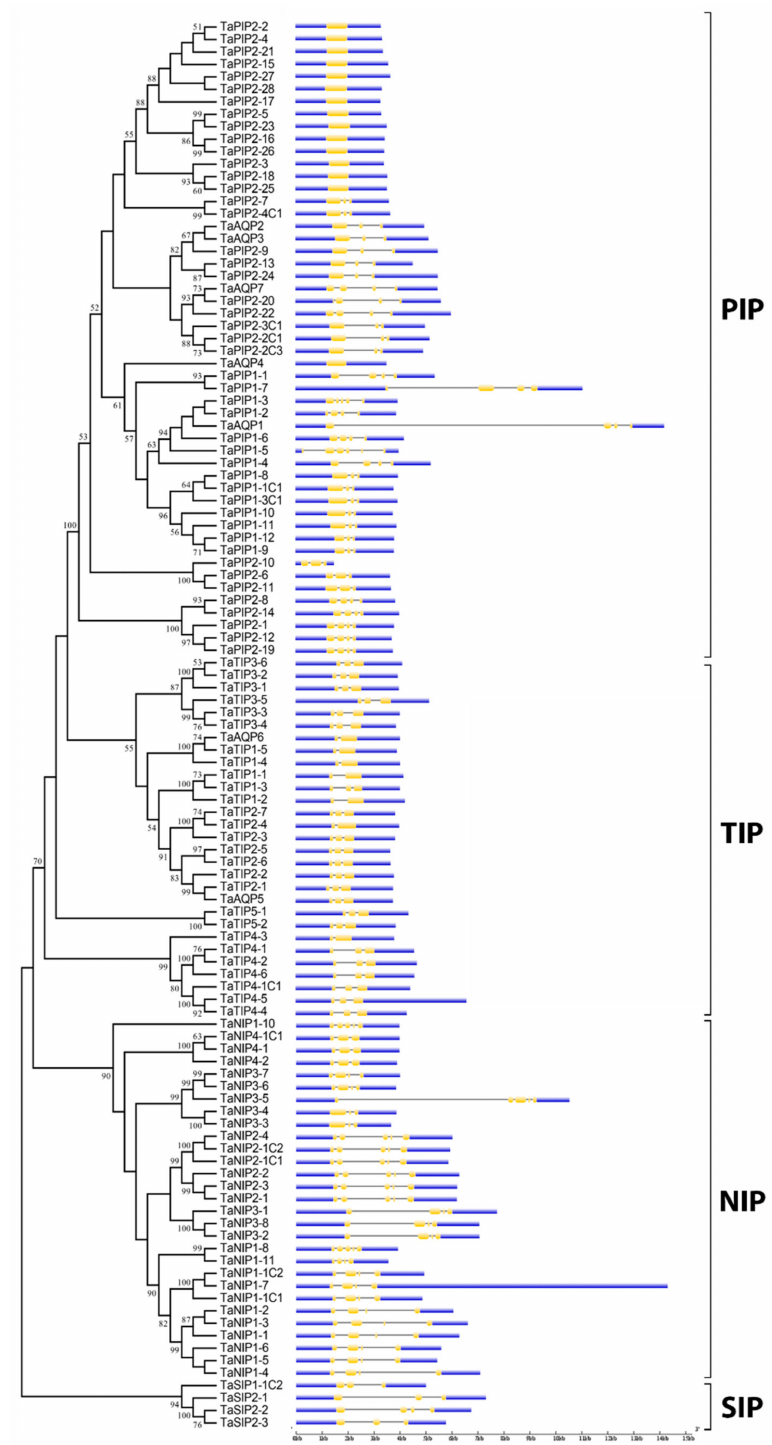
Figure 2. Exon-intron structure of wheat AQPs. In yellow, exons; in blue, the 3 (cid:48) and 5 (cid:48) UTR regions; and in the grey lines,